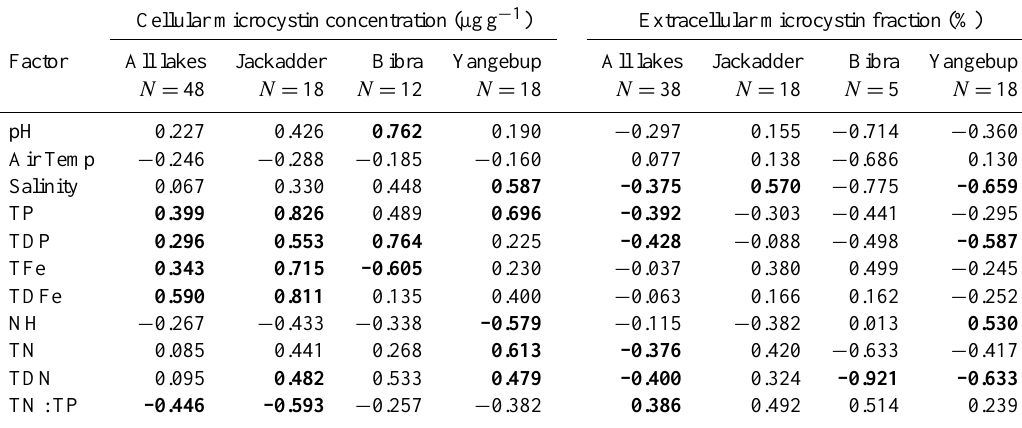
Significant ( p< 0.05) correlations are highlighted in